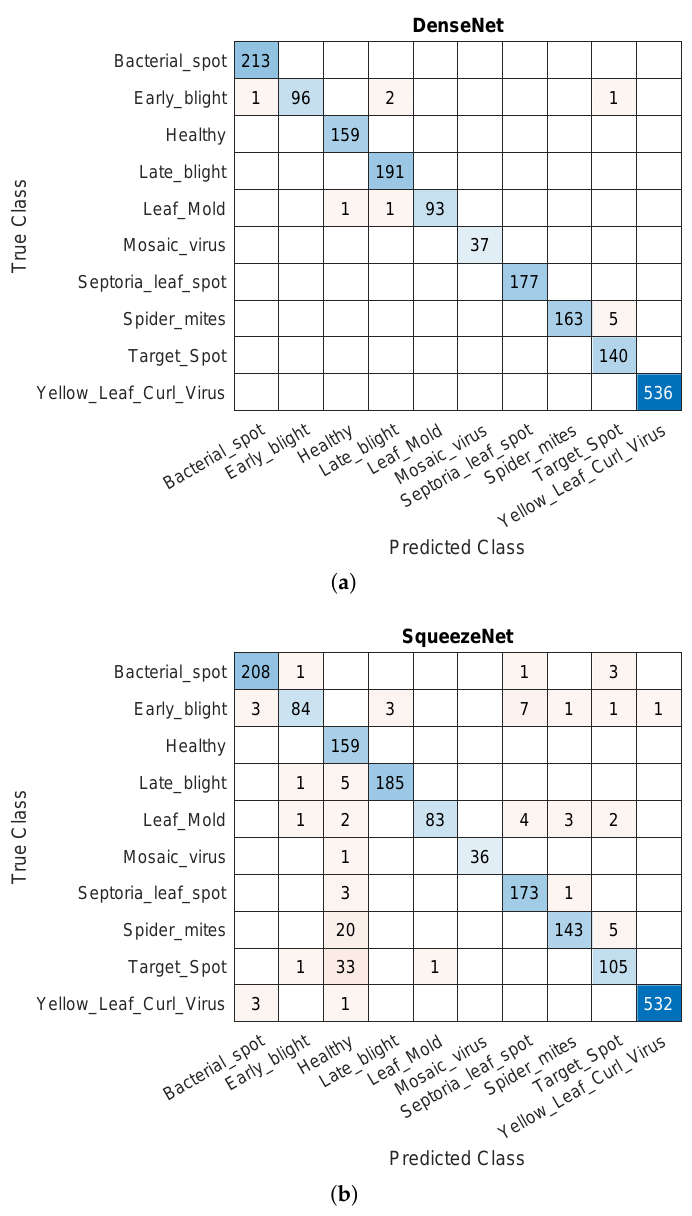
Figure 7. Sample confusion matrices for the DensNet-201 and SqueezeNet models using 90% of the data for training. ( a ) DenseNet-201; ( b )